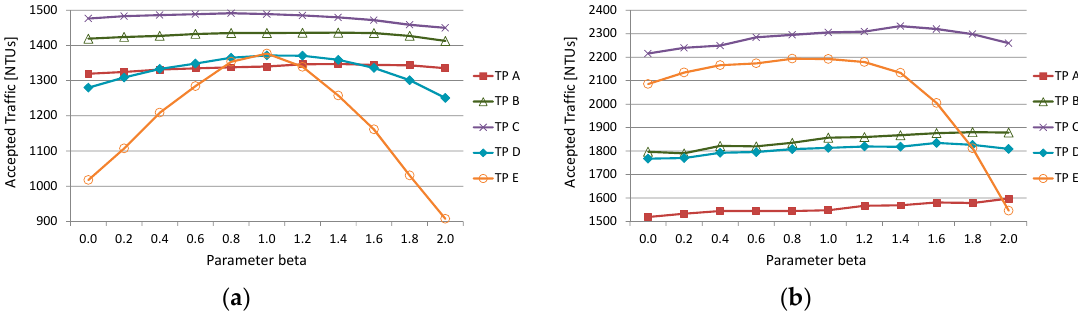
Figure 7. Tuning of the SAUR algorithm—accepted traffic as a function of tuning parameter β for the Euro28 network with different traffic profiles: ( a ) 10,000 transponders, ( b ) 20,000 transponders.